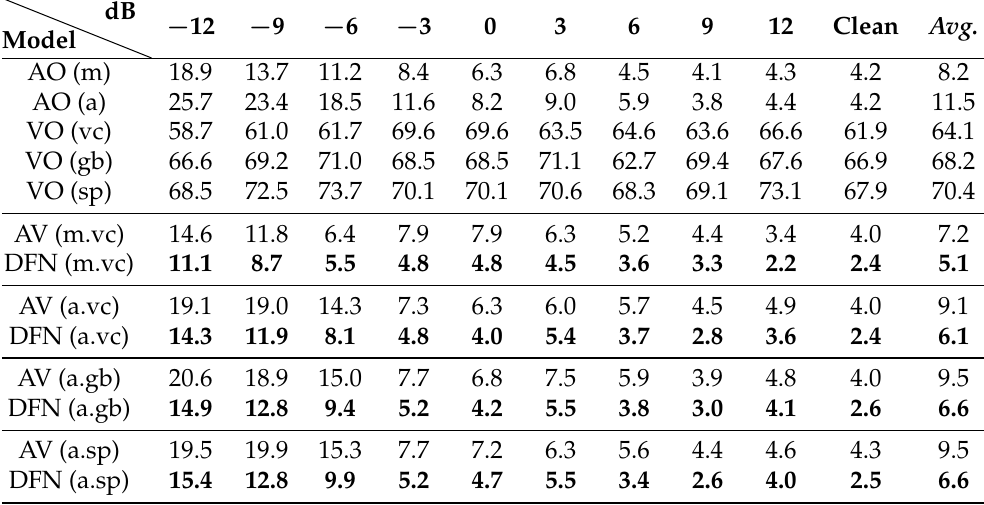
Table 8. Performance of the audio-visual and uni-modal speech recognition (WER [%]). AO: audio only. VO: video only. AV: AV baseline [9]. DFN: proposed DFN fusion. m: music noise. a: ambient noise. vc: clean visual data. gb: visual Gaussian blur. sp: visual salt-and-pepper noise.